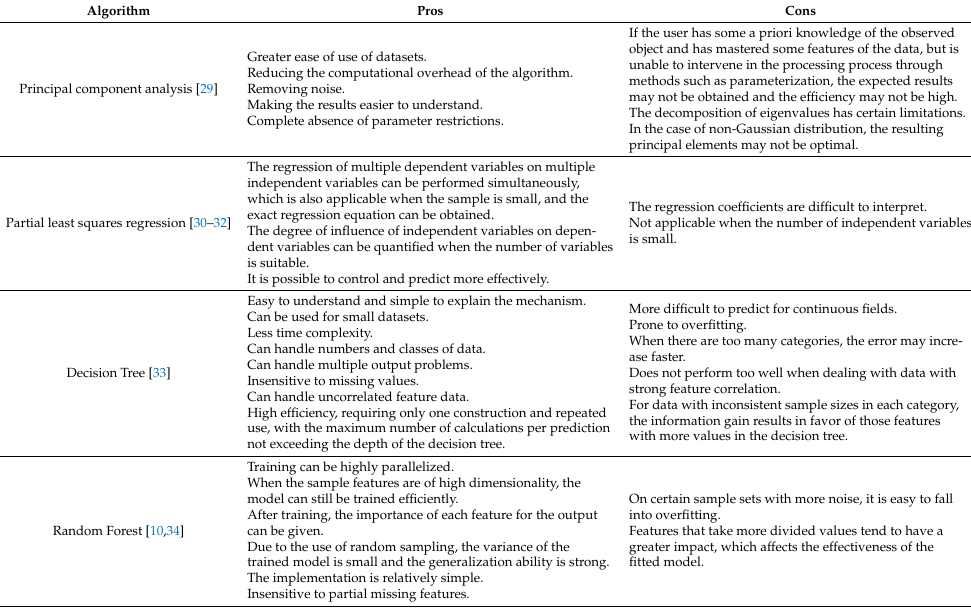
Table 4. Comparison of different rule-based machine learning algorithms for intelligent identification of